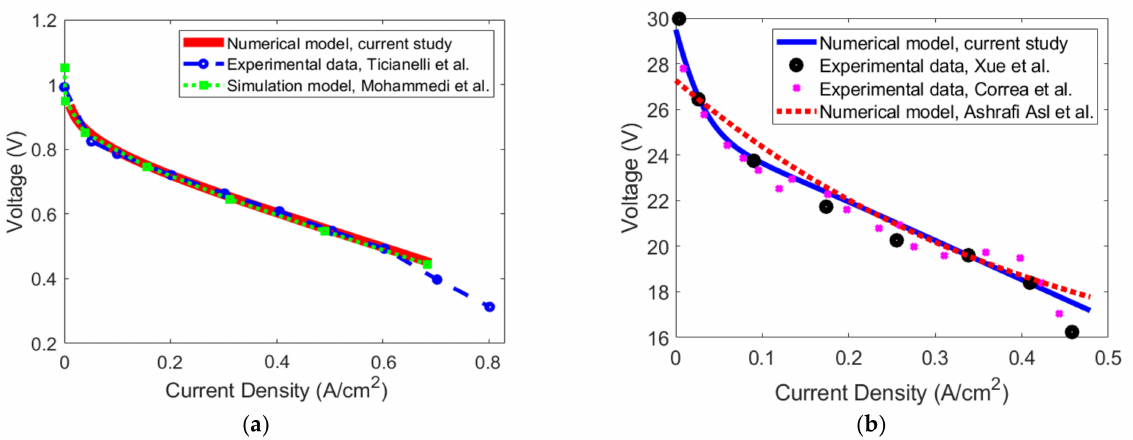
Figure 9. Validation results of the developed PEMFC model at low current densities: ( a ) model com- parison with the experimental data of Ticianelli et al. [42] and simulations of Mohammedi et al. [43]; ( b ) model comparison with the 500 W BCS stack using the experimental data of Xue et al. [44], Correa et al. [45], and simulation data of Sharifi-Asl et al.